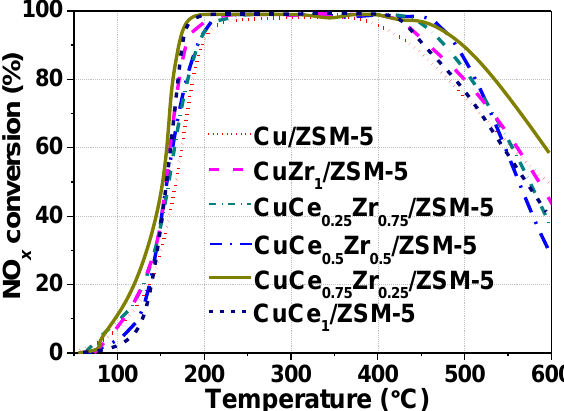
Figure 6. Catalytic activities for NO x reduction by NH 3 for Cu/ZSM-5 and CuCe x Zr 1 − x /ZSM-5 catalysts ( x = 0, 0.25, 0.5, 0.75 and 1).